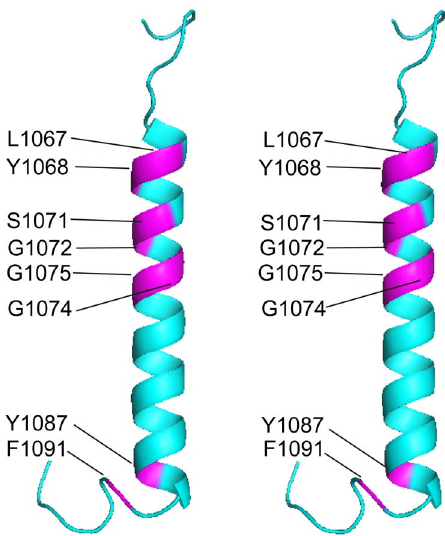
Figure 5. Putative interacting face of a L TM. Stereo view ribbon representation of the a L TM domain (Val-1058 to Lys-1097) with residues most affected by heterodimerization with b 2 shown in